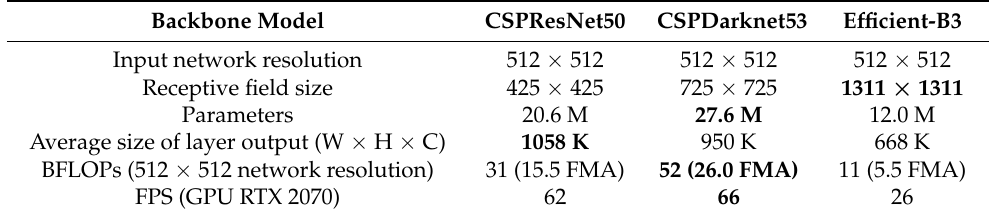
Table 1. Comparison of CSPResNet50, CSPDarknet53, and Efficient-B3 (The bold indicates the best value in parameter aggregation.).